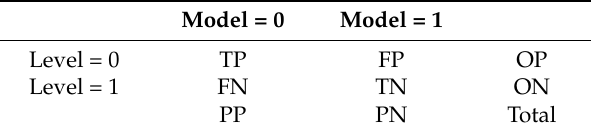
Table 7. Classification table.